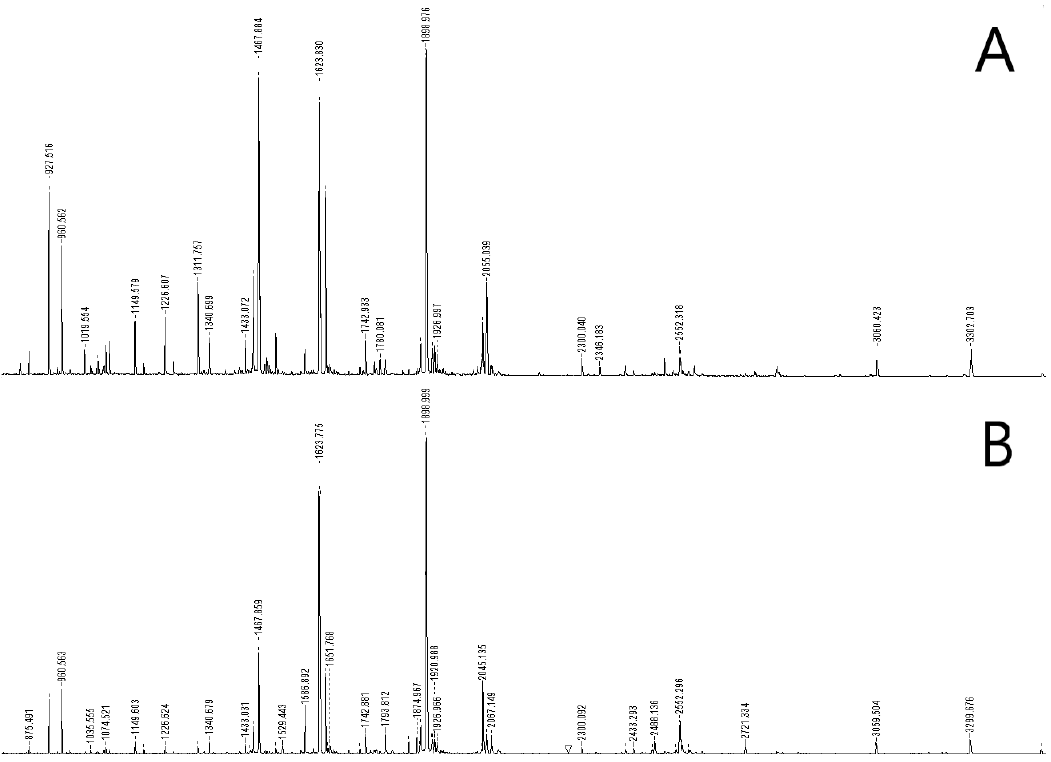
Figure 3. HSA peptide mass spectra after on-chip trypsin digestion ( A ) and in-vial digestion ( B ).